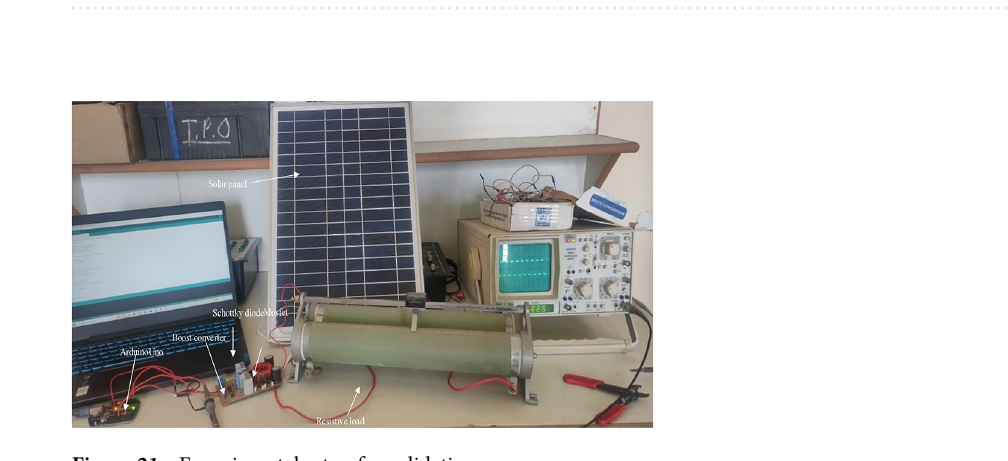
Figure 21. Experimental setup for